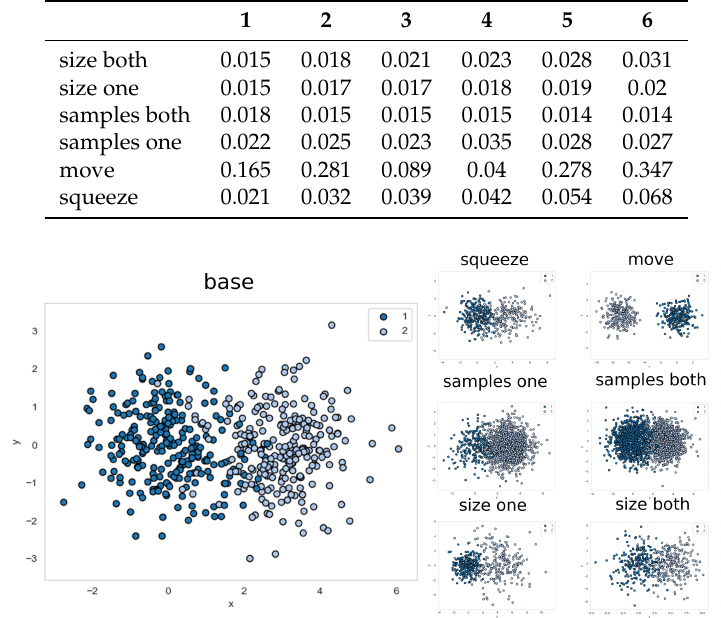
Figure 6. Analytical drifting data sets used for determining properties of CGEM. The base data set is displayed on the top with the six modifications below. Each modification is evaluated in multiple linear intensities, while the figure displays the most intense